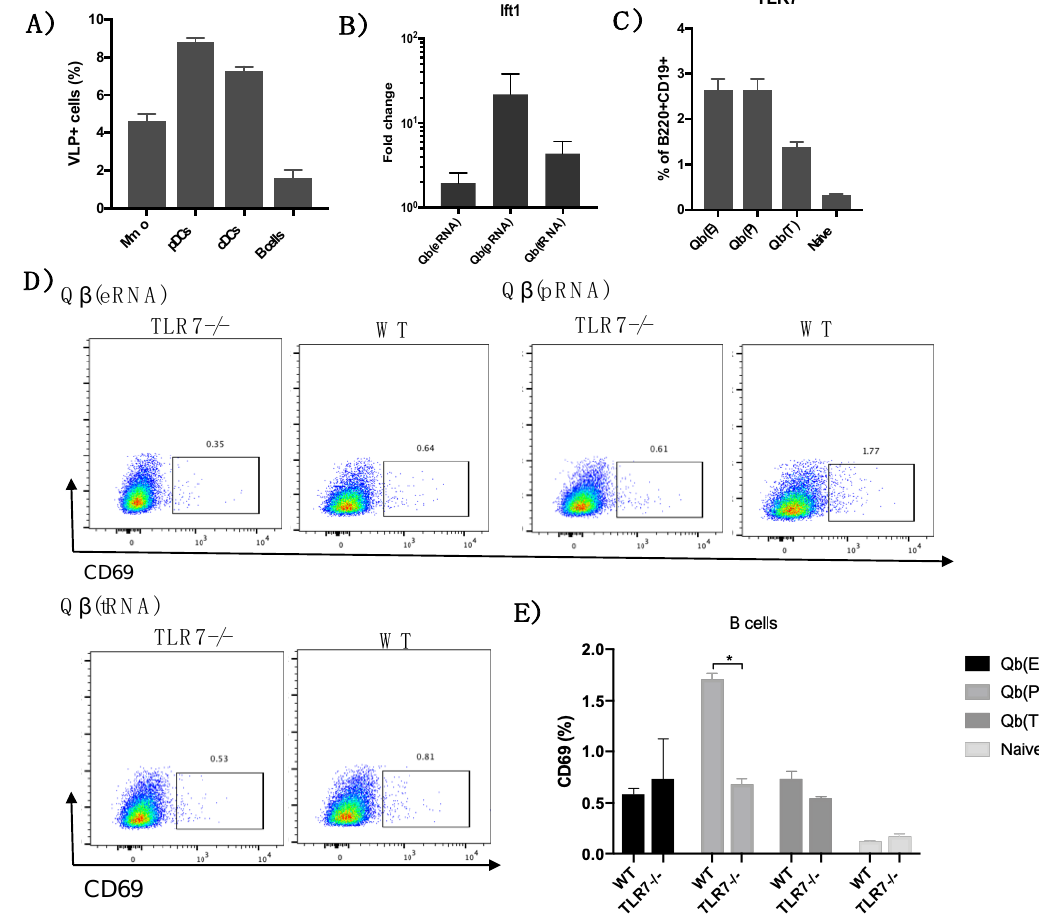
Figure 4. TLR7 dependent immune response of B cells and DCs. A) Axis indicates the percentage of macrophages (Mmo), pDCs, cDCs and B cells positive for E. coli -expressed Qβ 24h post injection. B) Induction of the ift1 gene on 3T3 cells treated with serum of mice immunised with VLPs loaded with different RNAs 20h post immunisation, measured by RT-qPCR. Data are presented as fold changes compared to the average cells treated with sera of naïve mice. C) TLR7 expression in B cells (B220 + CD19 + ) from immunised mice 24h post immunisation. D) CD69 expression on splenic B cells 24h post immunisation of WT and TLR7 knock out mice. Gated on B cells (B220 + CD19 + ). E) Bar plot of CD69 expression on B cells 24h post immunisation. Data represented as mean + SEM n = 3 mice. * P < 0.04. Results are representative of 2 independent experiments.